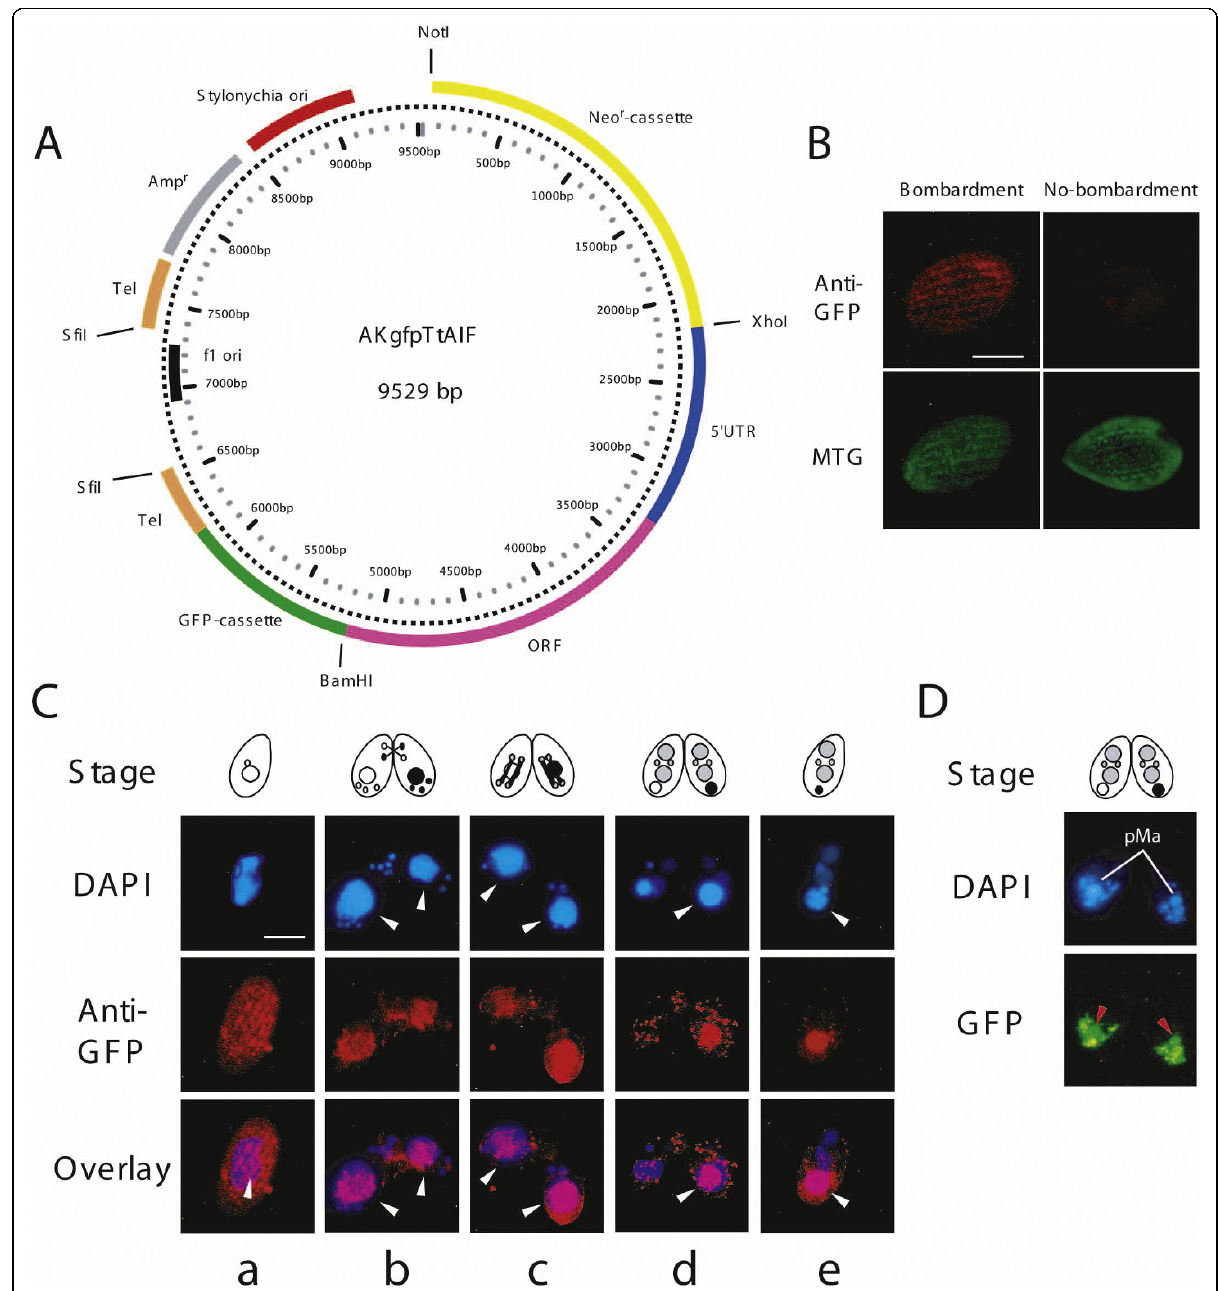
Figure 3 Translocation of AIF from mitochondria to parental macronucleus . A. Map of expression vector, named AKgfpTtAIF, with neomycin resistance cassette (Neo r -cassette), 5 ’ UTR and ORF of AIF , codon-optimized GFP (GFP-cassette), replication origin derived from Stylonychia lemnae and telomeres from Tetrahymena . Neomycin resistance is expressed under control of b -tubulin promoter. Before biolistic bombardment, the plasmid was digested with SfiI to expose telomere sequences on both ends. B. After biolistic bombardment, cytoplasmic localization of AIF::GFP was detected using a -GFP. This fluorescent pattern was coincided with MitoTracker Green (MTG). No-bombardment indicates non-transformed wild-type cell. Scale bar in photograph indicates 10 μ m. C. Translocation of AIF::GFP was visualized with a -GFP antibodies. White arrows indicate parental macronucleus. Overlay represents fusion image of blue (nuclei) and red (AIF::GFP) fluorescence. Scale bar in photograph indicates 10 μ m. D. Fluorescence microscopy of living cells expressing AIF::GFP at the stage of MacIIp. Red arrows indicate AIF::GFP in parental macronuclei. pMa denotes parental